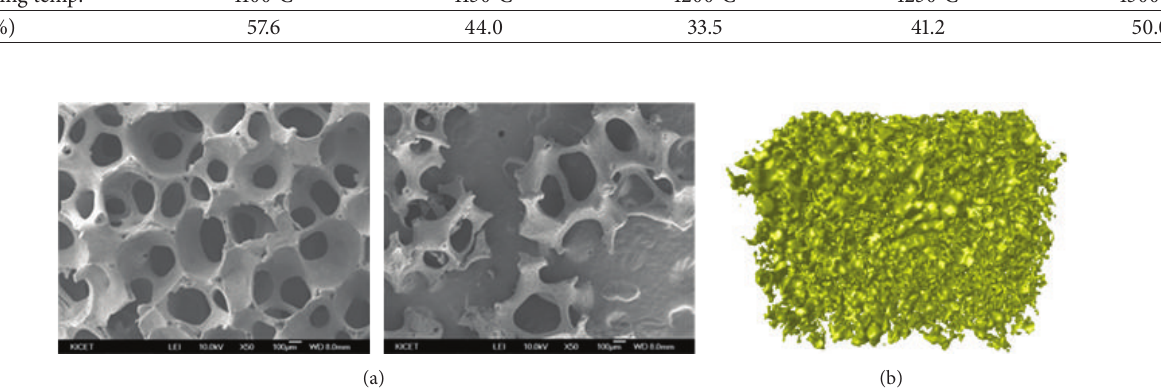
Table 1: HA contents of 60TCP40HA sintered body, which is calculated by ISO 13779-03. Sintering temp.